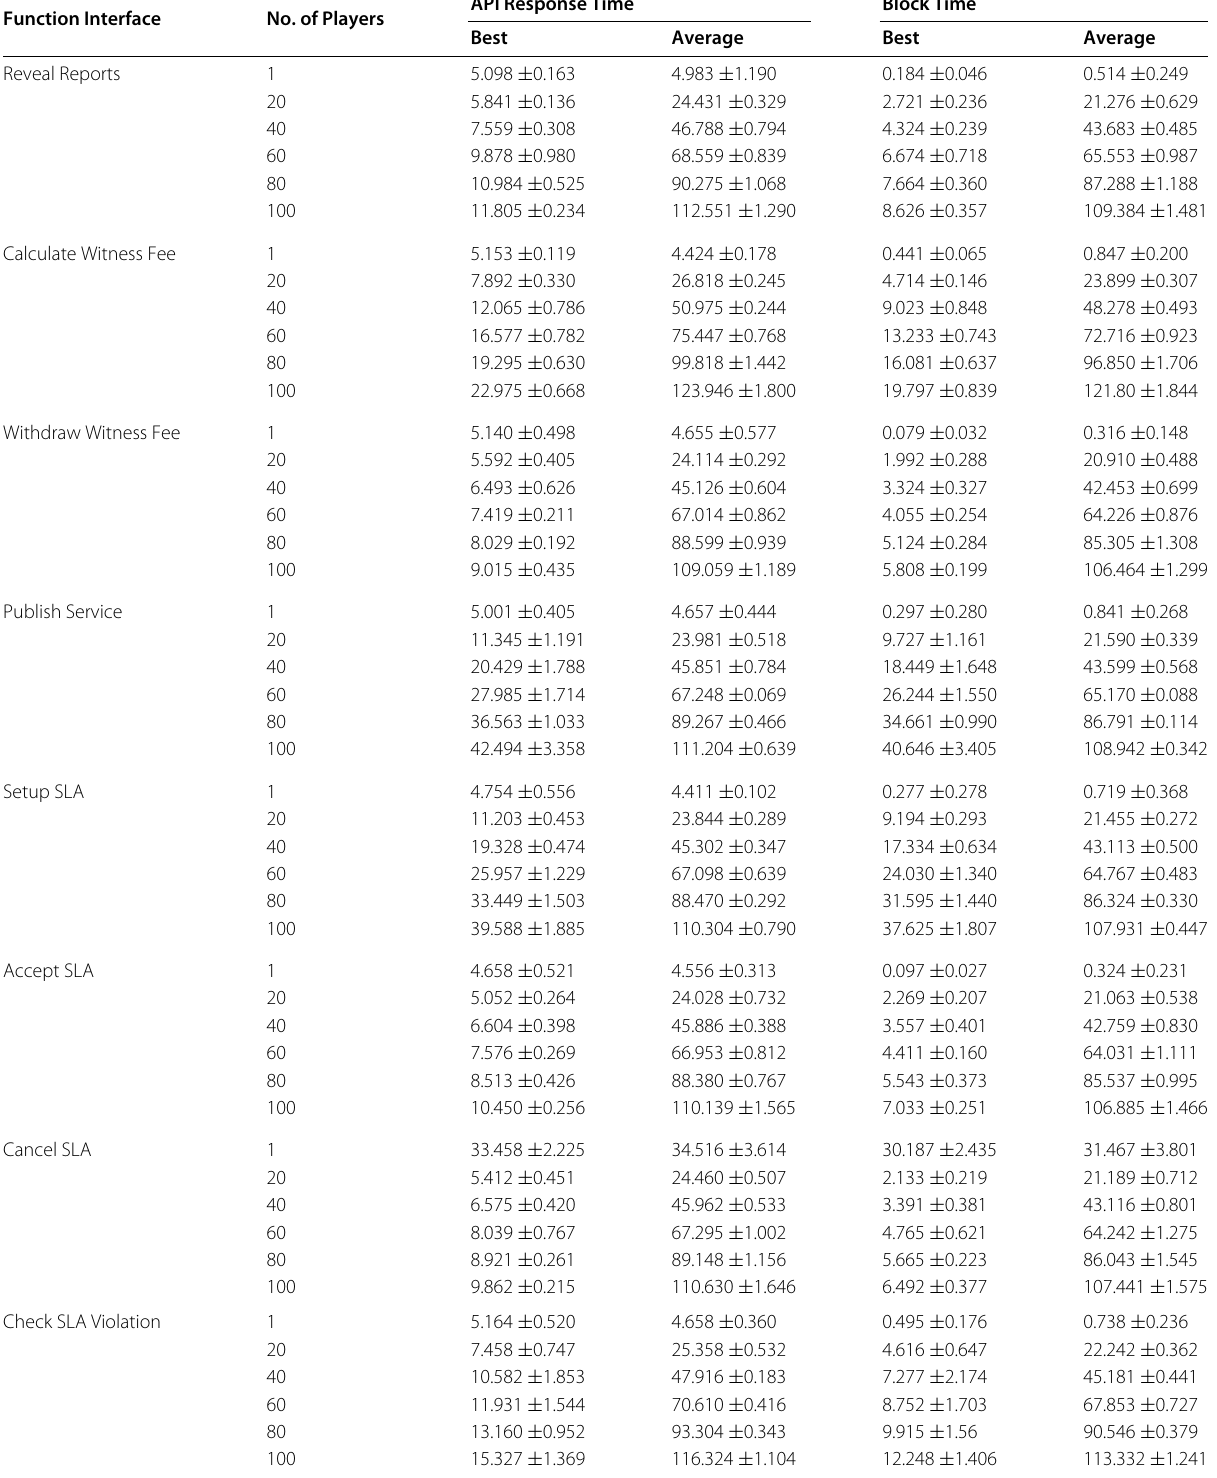
Table 1 Execution latency of the AWESOME contracts with different player numbers (s) ( Continued